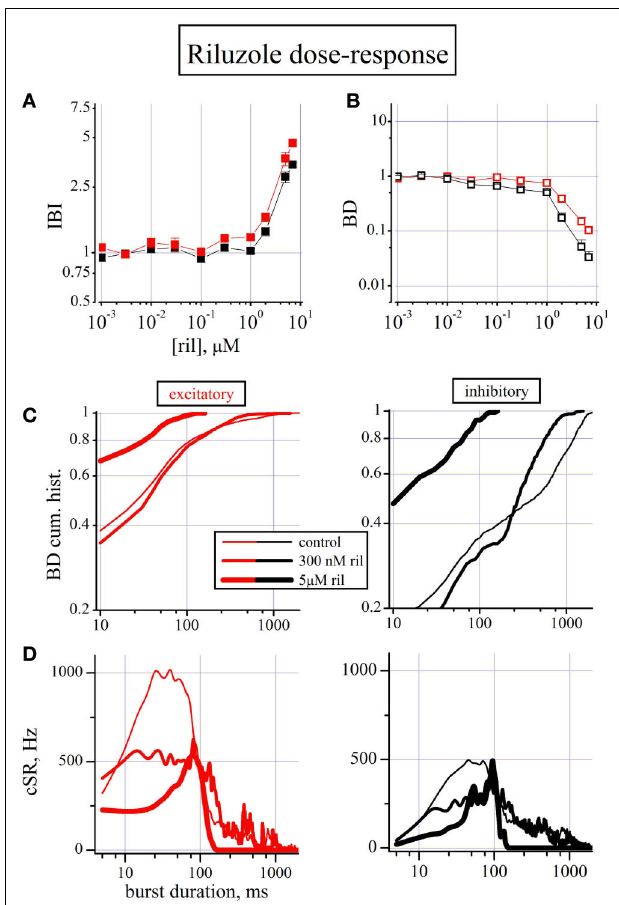
FIGURE 5 | The dose–response effects of riluzole. (A,B) Dose–response curves for IBI and BD evaluated for the excitatory (red symbols) and inhibitory (black symbols) cluster of neurons (total number of cells: 176, 68, respectively). (C) BD cumulative histogram data from one representative experiment out of four experiments with 44 excitatory (left) and 17 inhibitory (right) cells. Data are shown in thin, medium and thick lines for control, 300 nM and 5 µM ril, respectively. For the single experiment shown, mean values of IBI and BD (in parenthesis the inhibitory cells) in control were, respectively: 25 ± 1.3 s, (23 ± 1.6); 100 ± 15 ms (602 ± 34). The values in 300 nM ril were: 31 ± 2 s, (26.8 ± 0.9); 83 ± 10 ms (331 ± 29) and in 5 µM ril were: 83.3 ± 6 s, (81.8 ± 8); 15 ± 2.6 ms (30 ± 9). (D) cSR is plotted versus burst duration, for excitatory (left) and inhibitory (right) cells. Data are shown in thin, medium and thick lines for control, 300 nM and 5 µM ril,